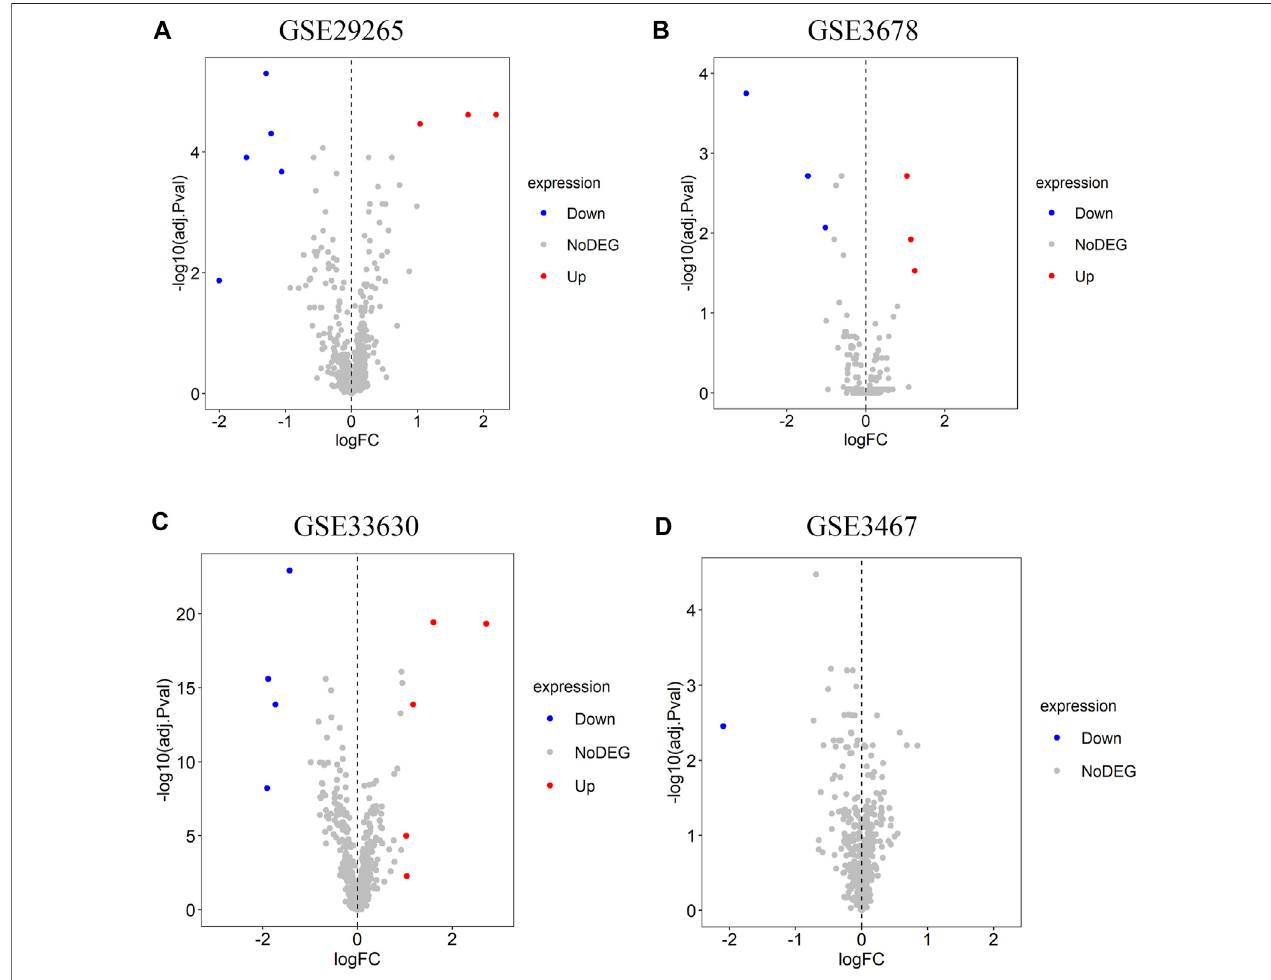
FIGURE1| Identi fi cation ofdifferentially expressed lncRNAs ineach dataset. (A) GSE29265, (B) GSE3678, (C) GSE33630, (D) GSE3467. Thered potsrepresent the up-regulated lncRNAs and the blue pots represent the down-regulated ones with the cutoff criteria of |logFC| > 1 and adjusted p < 0.05. The grey pots represent lncRNAs with no prominent expression